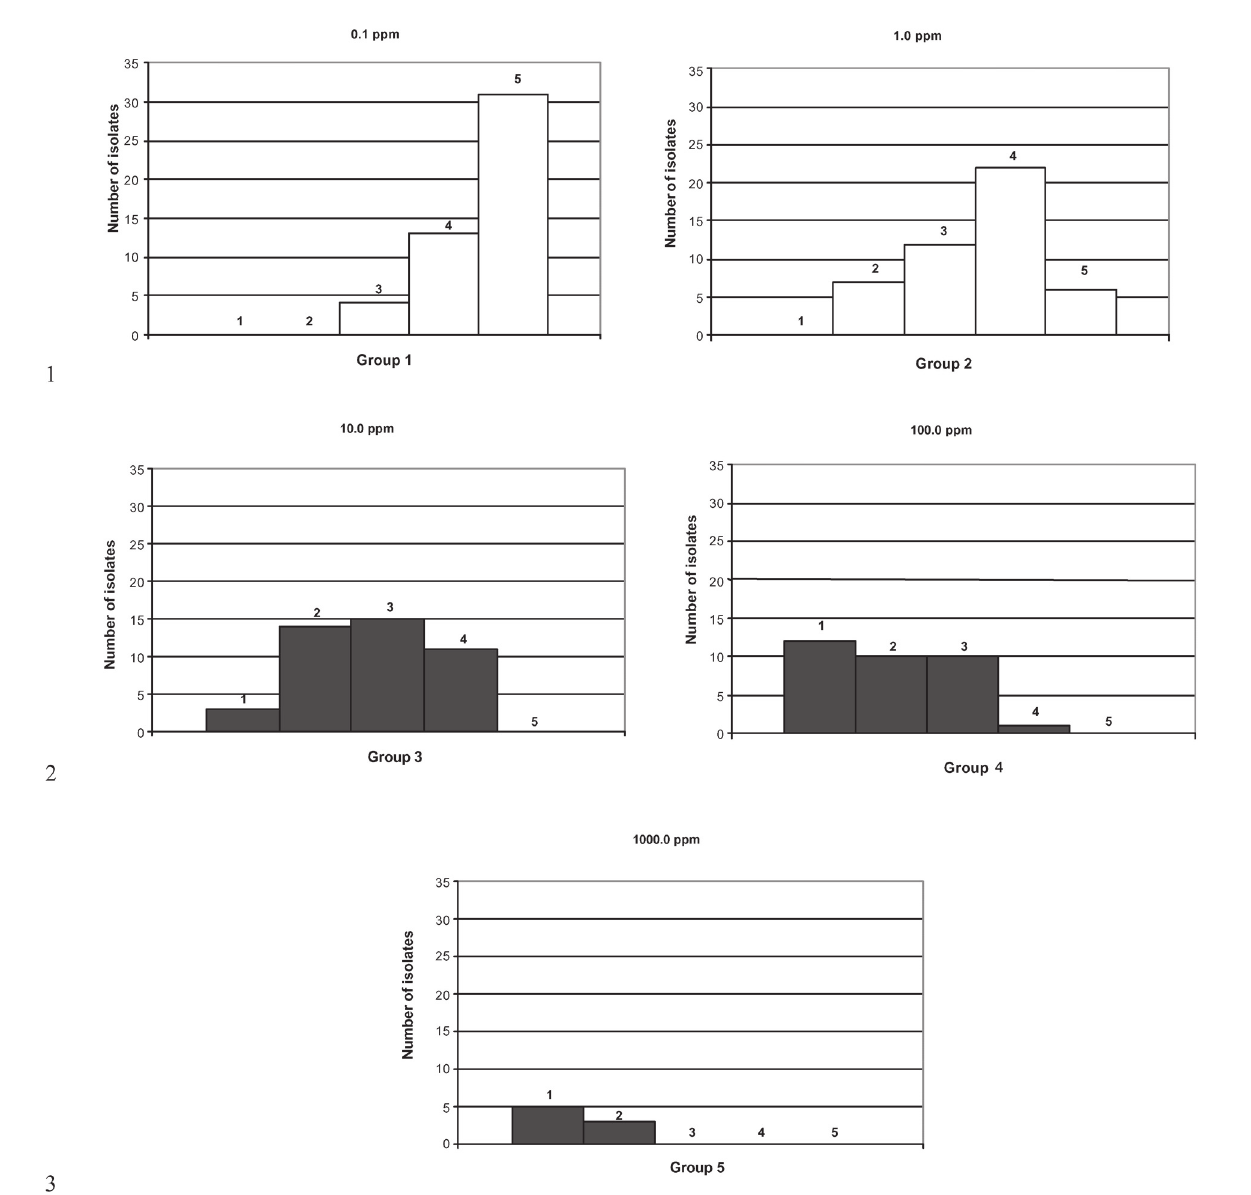
Fig. 1. Isolates of Alternaria solani classed into 5 groups based on percent growth in vitro with various concentra- tions of mancothane. Group 1 includes all isolates with colony growth between 0.1 and 20.9%; group 2, 21.0–40.9%; group 3, 41–60.9%; group 4, 61–80.9%; and group 5,